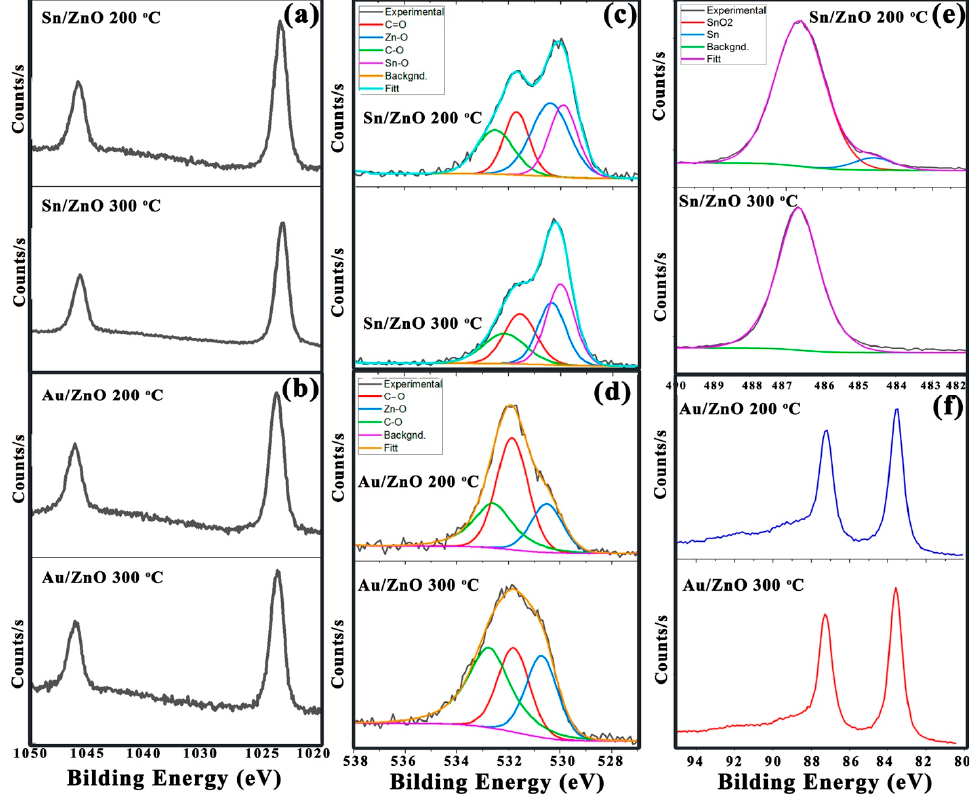
Figure 3. XRS characterizations of ZnO/Au and ZnO/Sn NR samples after annealing at 200 °C and 300 °C: ( a , b ) high-resolution spectra of ( a ) Zn2p in ZnO/Sn NR and ( b ) ZnO/Au NR; ( c , d ) high-resolution O1s spectra in ( c ) ZnO/Sn NR and ( d ) ZnO/Au NR; ( e ) high-resolution Sn 3d spectra in ZnO/Sn NR; and ( f ) high-resolution Au4f spectra in ZnO/Au NR.